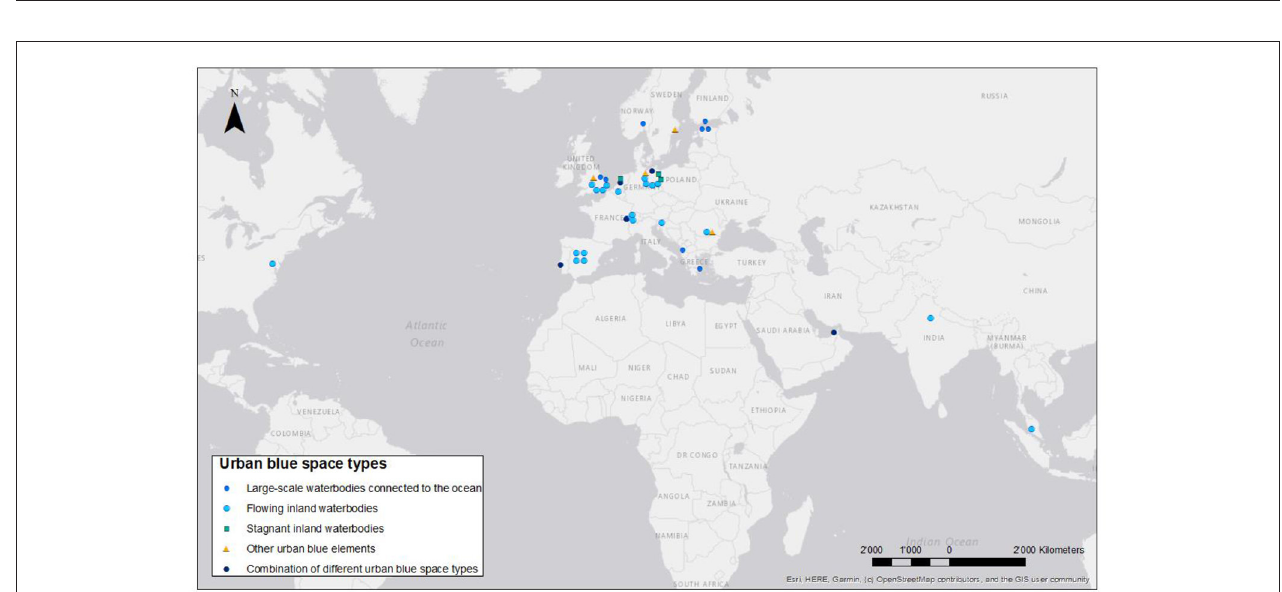
FIGURE 3 | Geographic distribution of the projects under study according to urban blue space types (Note: point symbols refer to the capitols of the project countries and do not reflect the project